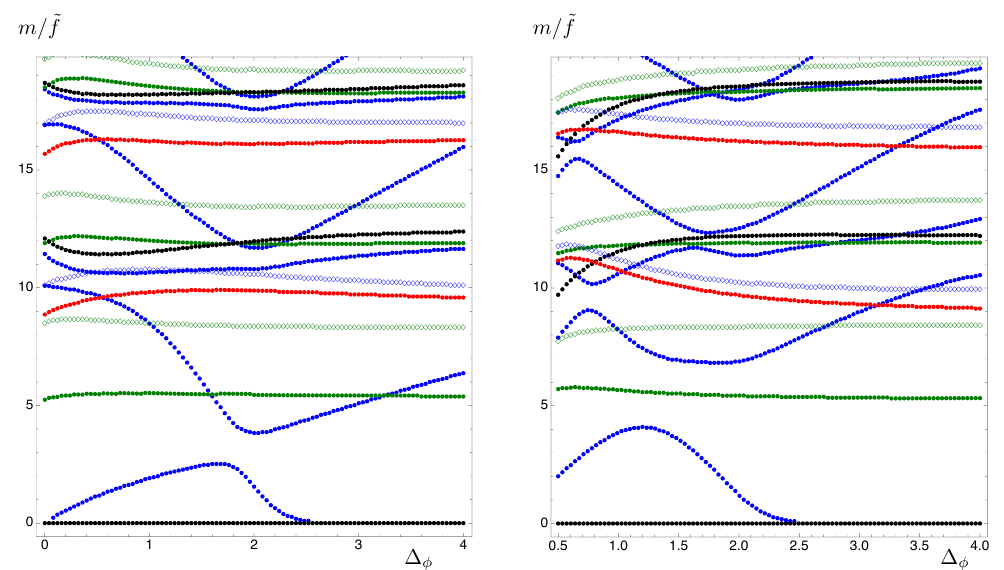
Figure 12 . Model IIA (left) and IIB (right). Spectrum as a function of ∆ φ for x F = 1 , ∆ = 3 , g 5 = 5 , ρ 1 = − 13 , ρ 2 = 8 , and φ A = 1 . 5 (Model IIA, left), φ B = 0 . 9 (Model IIB, right), normalized √ to the decay constant ˜ f ≡ f/ N C . The colour coding for the spectrum is: singlet scalar (blue), non-singlet scalar (blue diamonds), tensor (red), pseudoscalar (black), vector (green), axial-vector (green diamonds).